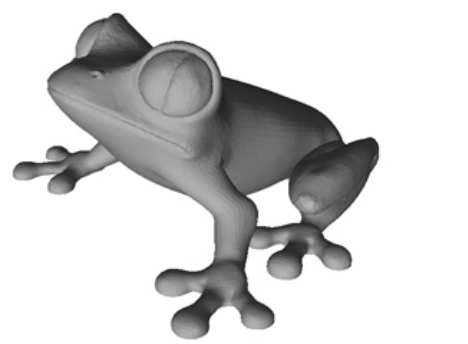
Figure 1. Visualization of the geometry of a printed object in CAD.